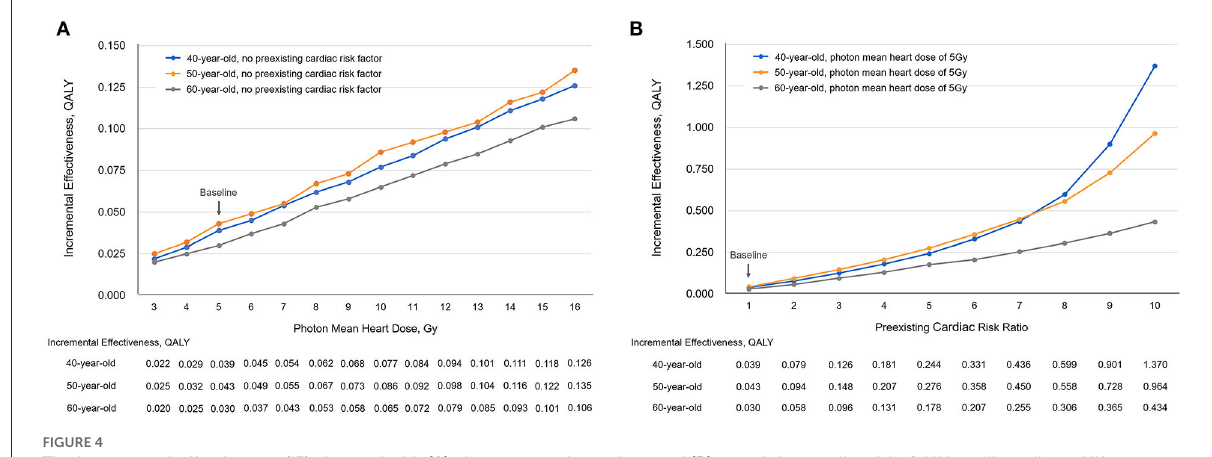
FIGURE4 The incremental effectiveness (IE) changed with (A) photon mean heart dose and (B) preexisting cardiac risk. QALY, quality-adjusted life-year; Gy,